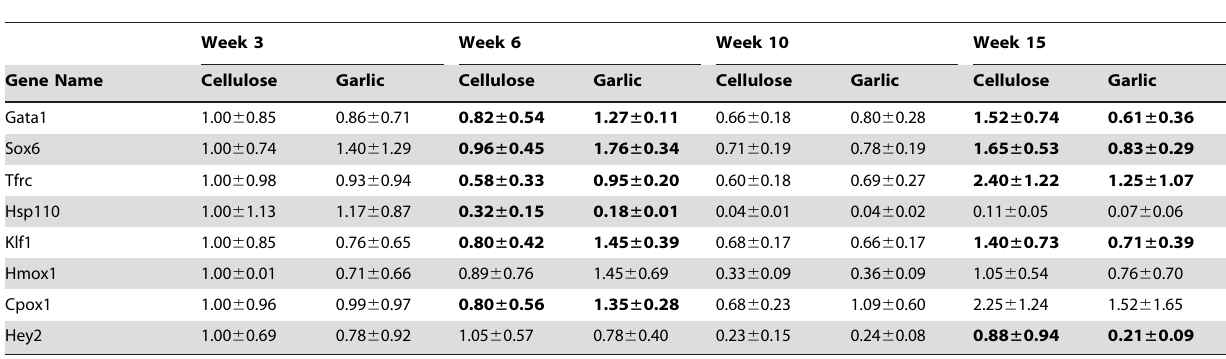
Table 2. QPCR analyses of selected genes in mouse bone marrow (n=3).